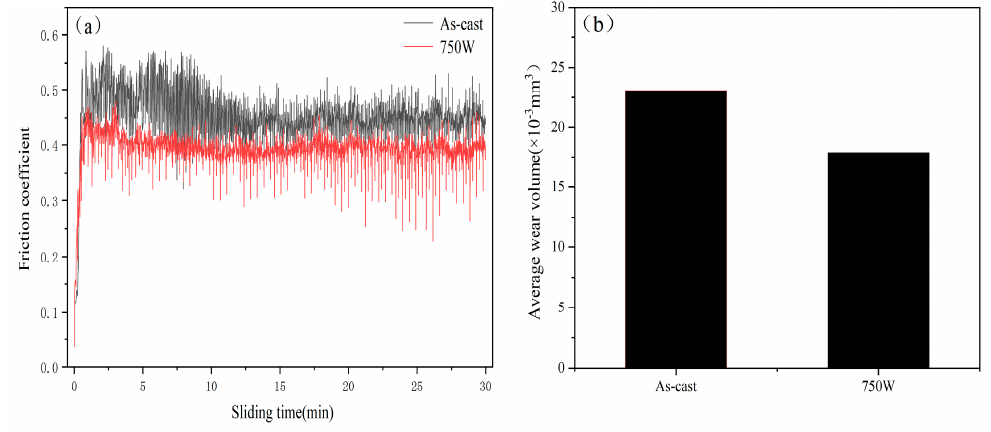
Figure 5. ( a ) Friction coefficient versus time curves; ( b ) wear weight loss